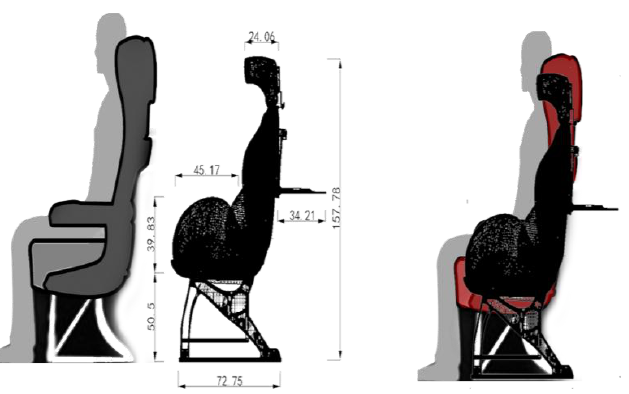
Figure 40. Seat to seat dimension.